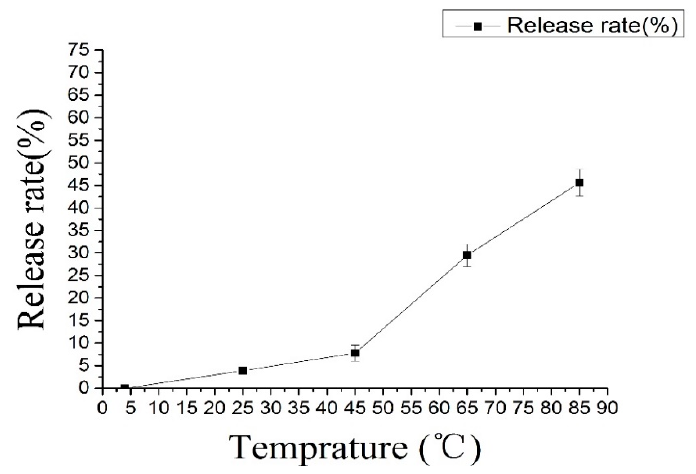
Figure 6. The effect of temprature on nanoliposomes.